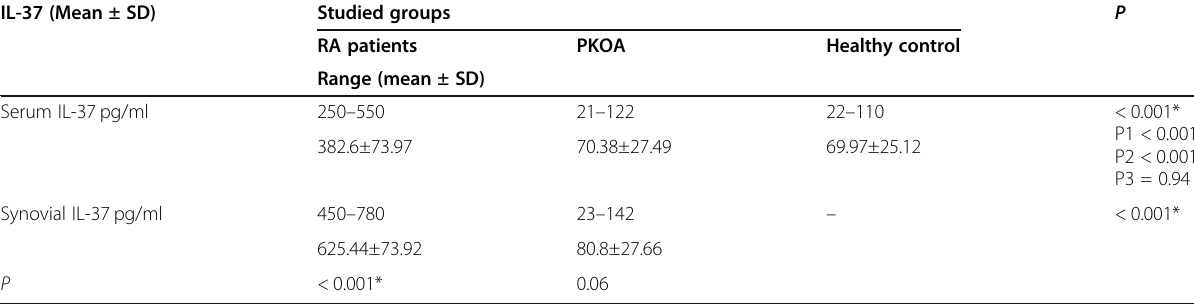
Table 3 Comparison between the mean serum and synovial levels of IL-37 in the studied groups IL-37 (Mean ± SD) Studied